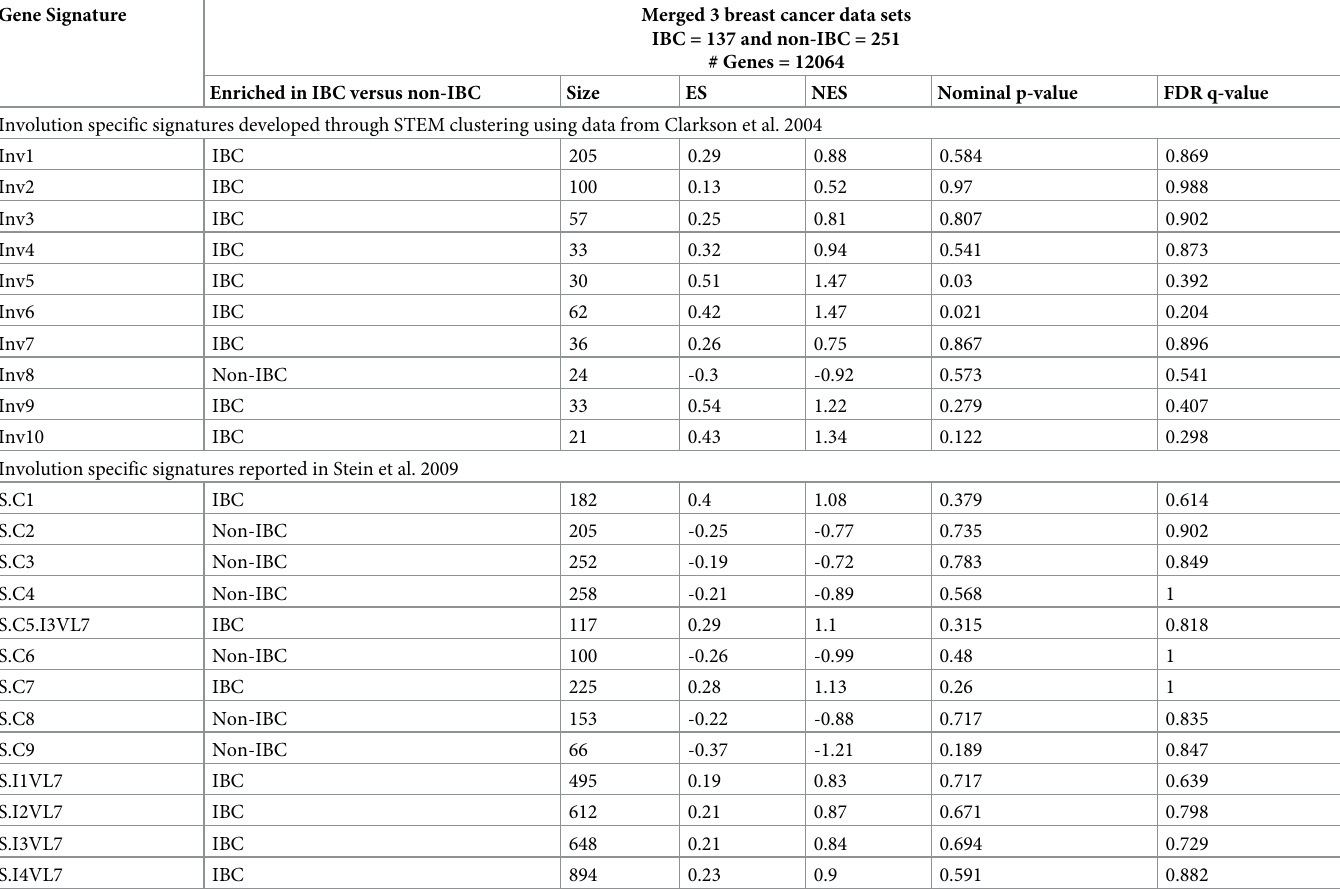
Table 4. GSEA results of involution-specific signatures in IBC versus non-IBC in the merged 3 breast cancer data sets. Gene